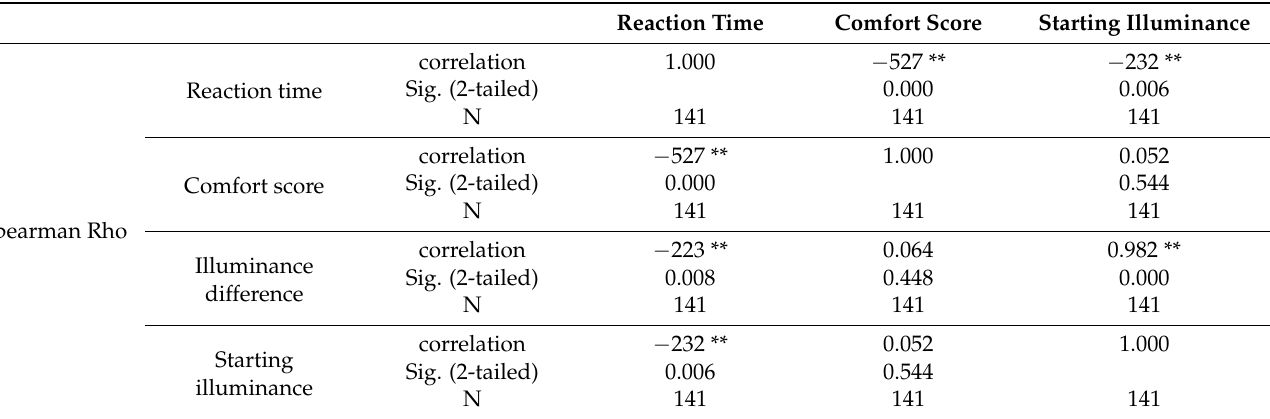
Table 7. Spearman correlation under decreasing